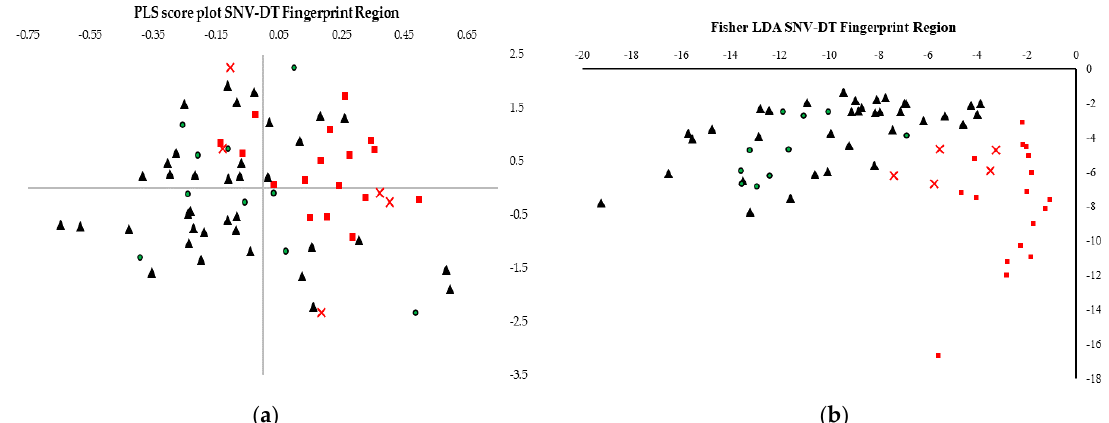
Figure 3. ( a ) the PLS score plot obtained using SNVDT transformed ATR-FT-MIR complete spectra under ERV. ( b ) Linear discriminate analysis performed on the extracted PLS scores. ( ▲ ) Foreign honey samples used in the training set ( ⬛ ); Maltese honey samples used in the training set ( ● ); foreign honey samples used in the validation set (x); Maltese honey samples used in the validation set. Maltese samples are depicted in red, whilst the foreign samples are depicted in black.